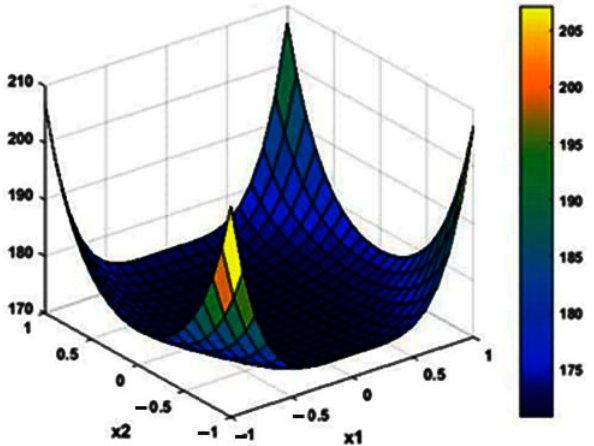
Figure 7. Surface h ( x ) for small range of x 1 ( t ), x 2 ( t ) and check the condition h ( x ) > 0 for stability of nonlinear time-variant system (31).